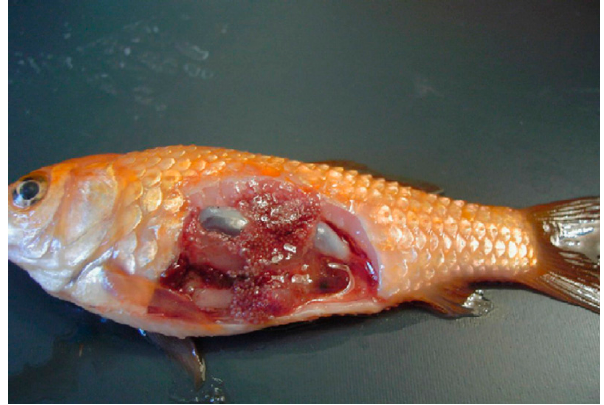
Figure 2. Gray and whitish nodules observed on internal organs of a goldfish ( Carassius auratus ) (From Passantino et al. 2008, reproduced with permission [54]).